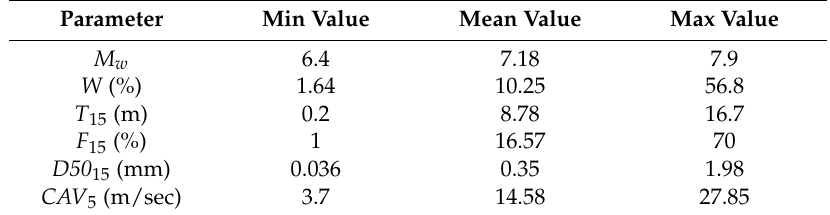
Table 1. Characteristics of whole case histories’ input parameters that were used to develop the ANN model and RSM equation.